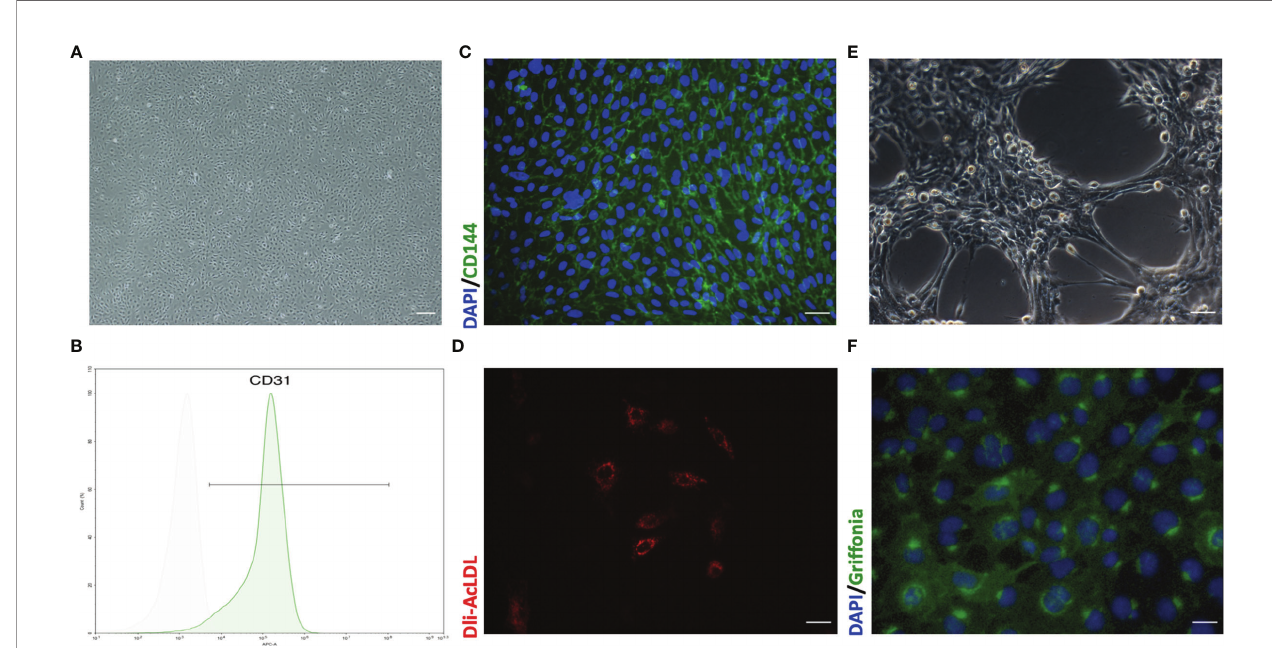
FIGURE 4 | Representative morphology and identi fi cation of primary mouse pulmonary microvascular endothelial cells (pMPMECs). (A) pMPMECs form a “ cobblestone- like ” morphology when cultured as a monolayer. Scale bar, 200 m m. (B) Flow cytometry analysis of CD31 expression of pMPMECs. Cells are incubated directly with anti- CD31 APC-conjugated antibody for 30 min and washed twice before analyzing. The isolated mouse pulmonary microvascular endothelial cells show that over 94% cells are CD31-positive. (C) Representative immuno fl uorescence images of pMPMECs co-stained with VE-cadherin (green) (also known as CD144) and DAPI (blue). The cells are fi xed, permeabilized, blocked, and then incubated with primary antibody at 4°C overnight. The cells are incubated with secondary antibody for 1 h at room temperature and counterstained with DAPI. Scale bar, 100 m m. (D) pMPMECs are incubated with Dil-AcLDL for 12 h Scale bar, 50 m m. (E) pMPMECs form a tube-like structure when cultured on Matrigel for 6 h Scale bar, 100 m m. (F) pMPMECs are stained with Griffonia lectin (green) after 1 h of incubation after fi xation. Counterstaining with DAPI (blue) demonstrates that all cells are positive for lectin-binding. Scale bar, 50 m